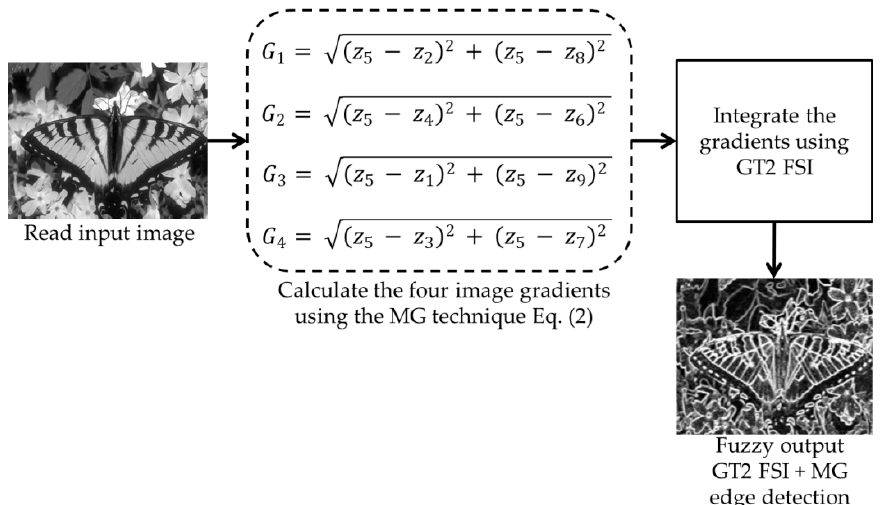
Figure 4. General diagram for general type-2 fuzzy Sugeno integral (GT2 FSI) + morphological gradient (MG) edge detection.